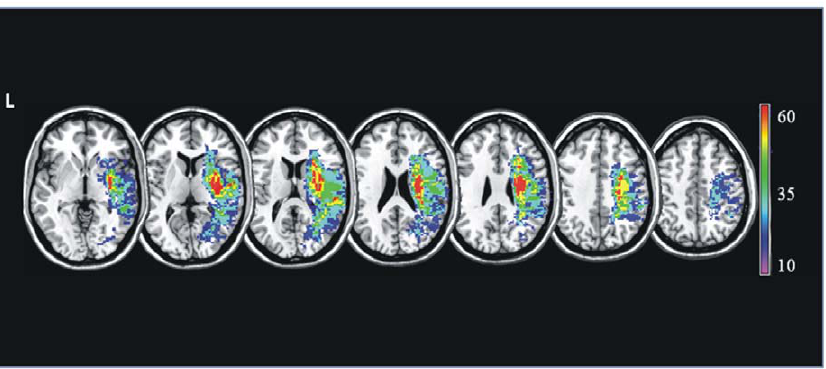
Figure 1. Lesion distribution. The damage evident in MRI images was reconstructed for each studied patient and plotted using MRIcro software. A T1-weighted template comprising 12 axial slices was used to demarcate lesions for every patient. The colour scale indicates the percentage of overlapping lesions across patients.